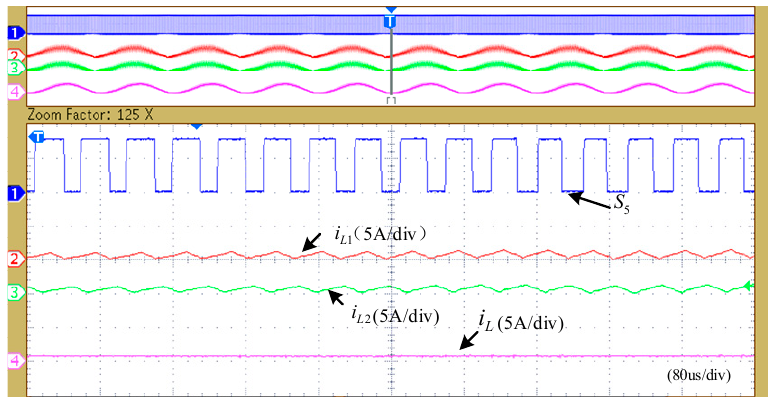
Figure 14. The enlarged drawing of Figure 13.